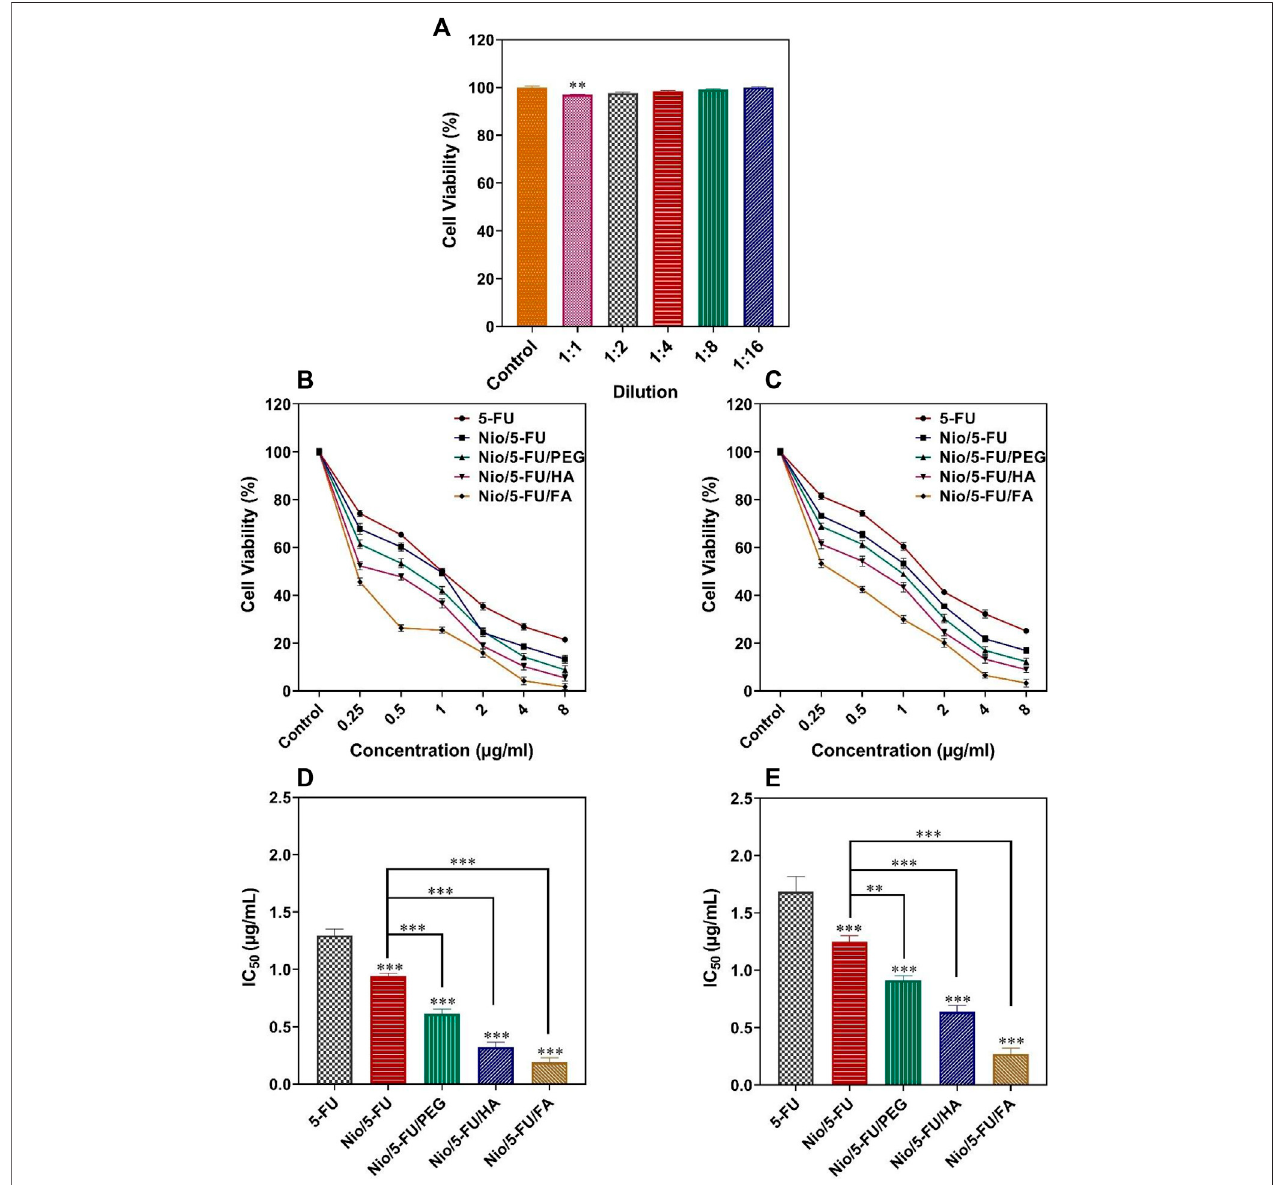
FIGURE5|(A) Percentagecellviabilityofdifferentdilutionsofniosomesonnon-malignantMCF10Acells. (B) Theeffectsof5-FU,Nio/5-FU,Nio/5-FU/PEG,Nio/5- FU/HA and Nio/5-FU/FA on the viability of MCF7 cells. (C) The effects of 5-FU, Nio/5-FU, Nio/5-FU/PEG, Nio/5-FU/HA and Nio/5-FU/FA on the viability of 4T1 cells. (D) Half-maximum inhibitory concentration (IC 50 ) values after 48 h of exposure of MCF7 breast cancer cells to 5-FU, Nio/5-FU, Nio/5-FU/PEG, Nio/5-FU/HA and Nio/5-FU/ FA. (E)